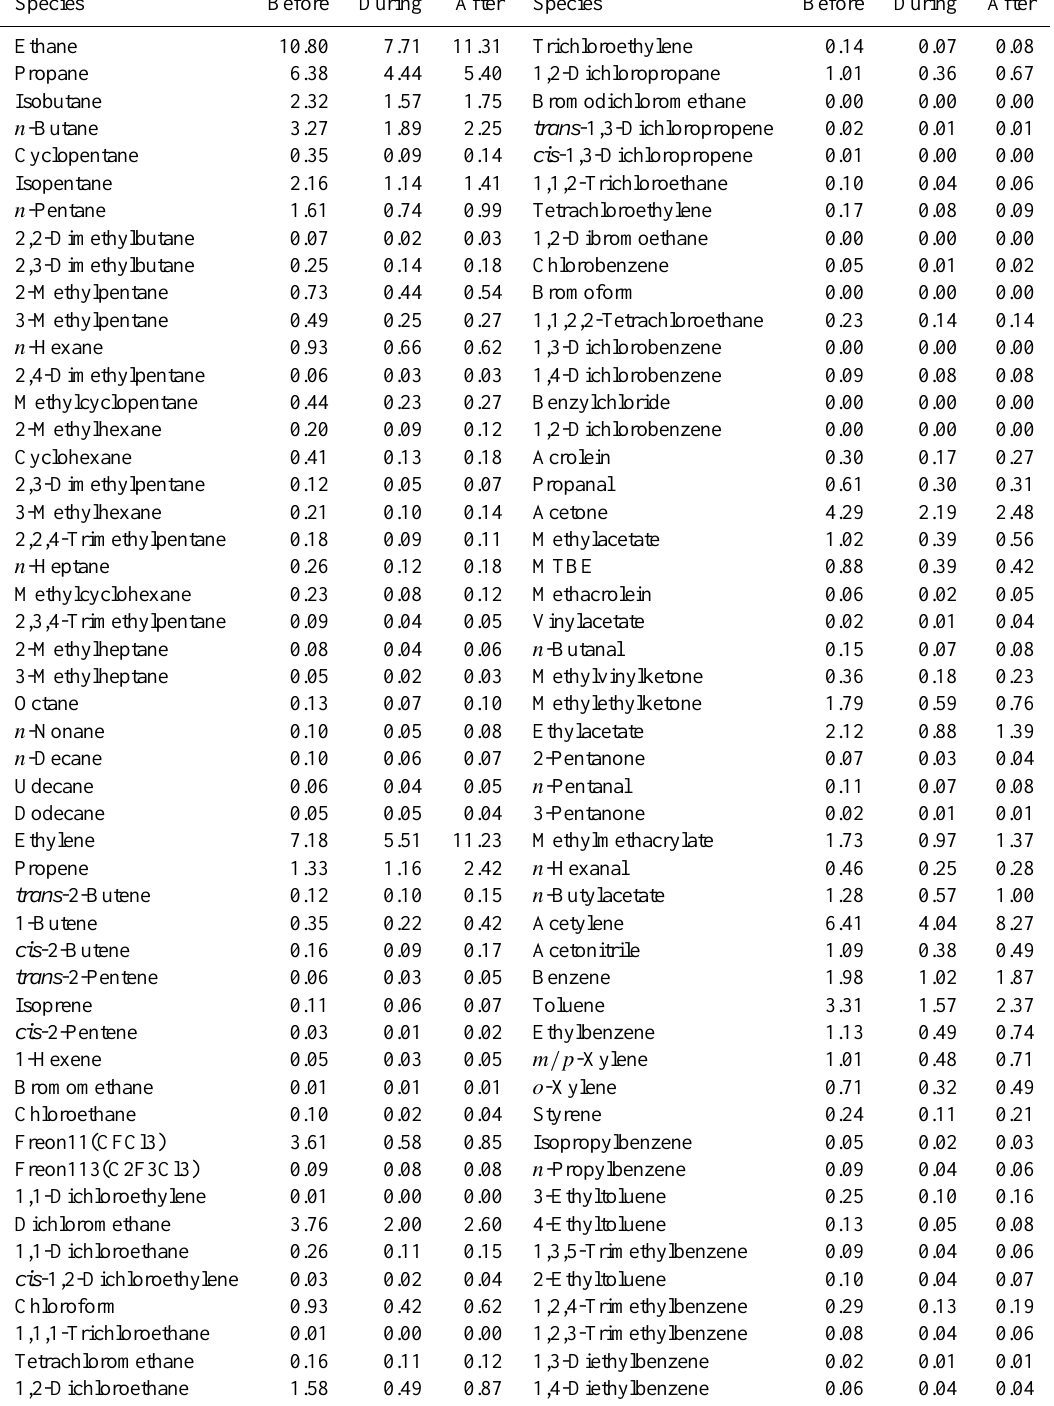
Table 2. Average mixing ratios (ppbv) of VOC species measured in Beijing. Species Before During After Species Before During After Ethane